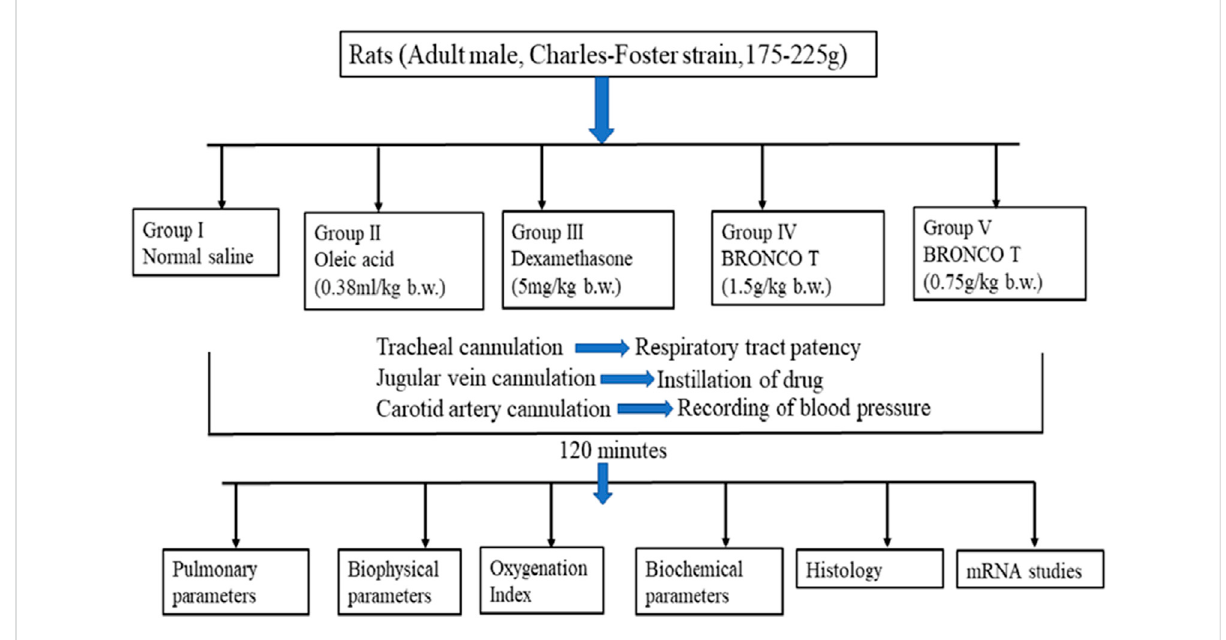
FIGURE 1 Study design showing the animal group, treatment schedule, and experimental